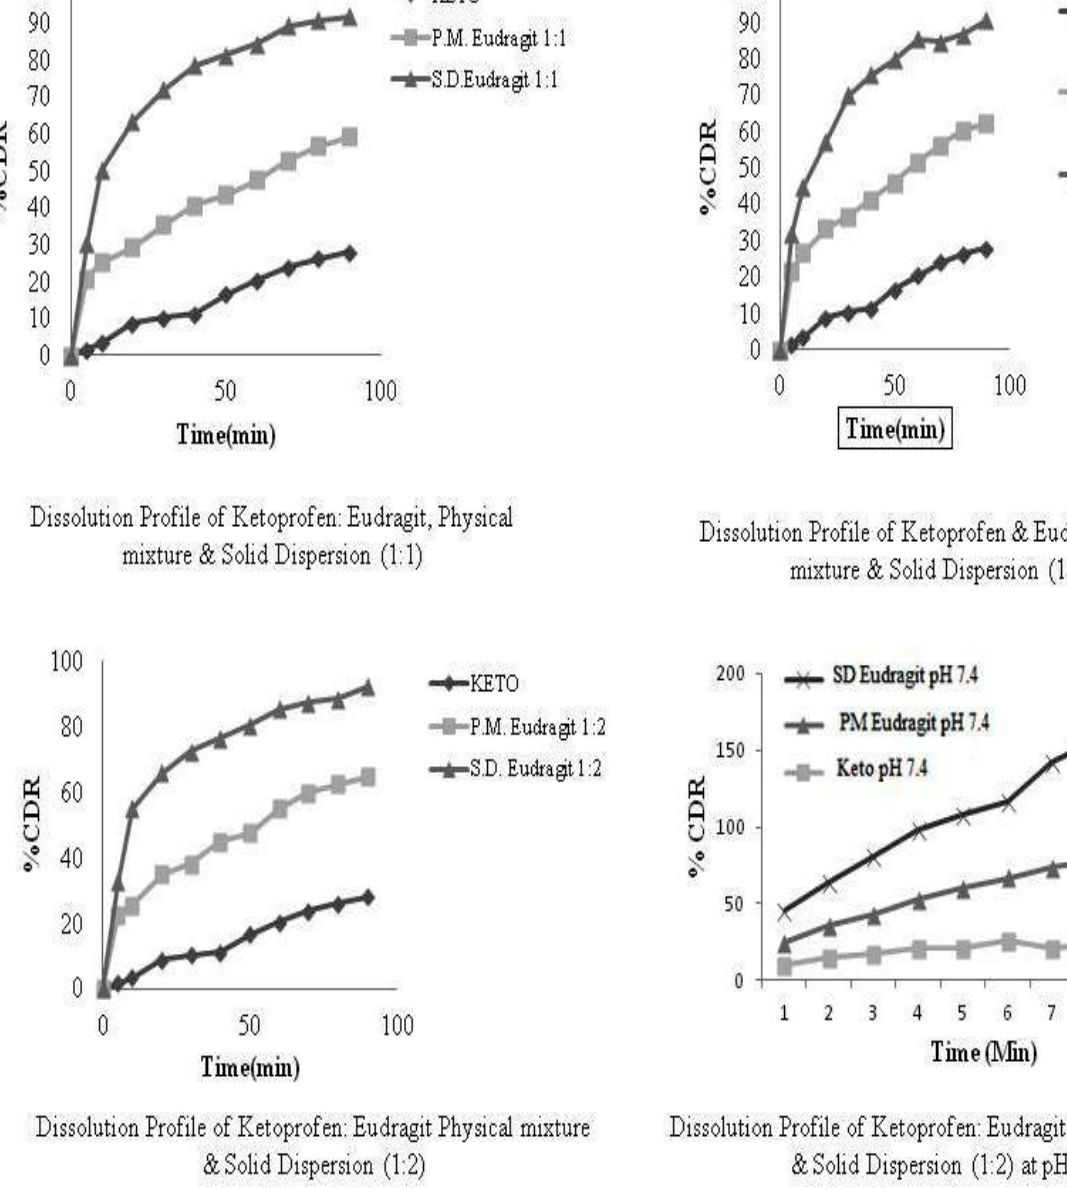
FIGURE 8 - Dissolution profile of Ketoprofen, physical mixture and solid dispersion with Eudragit S